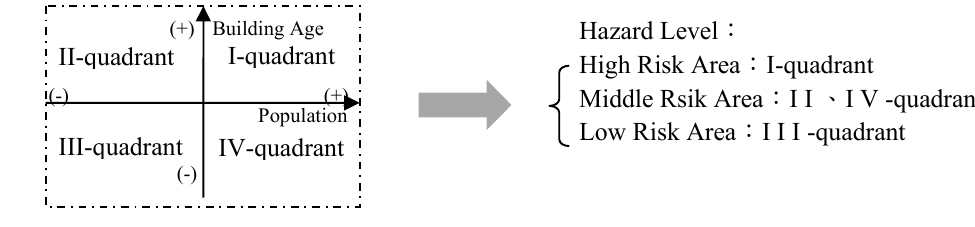
Figure 4. Quadrant diagram of hazard risk level.